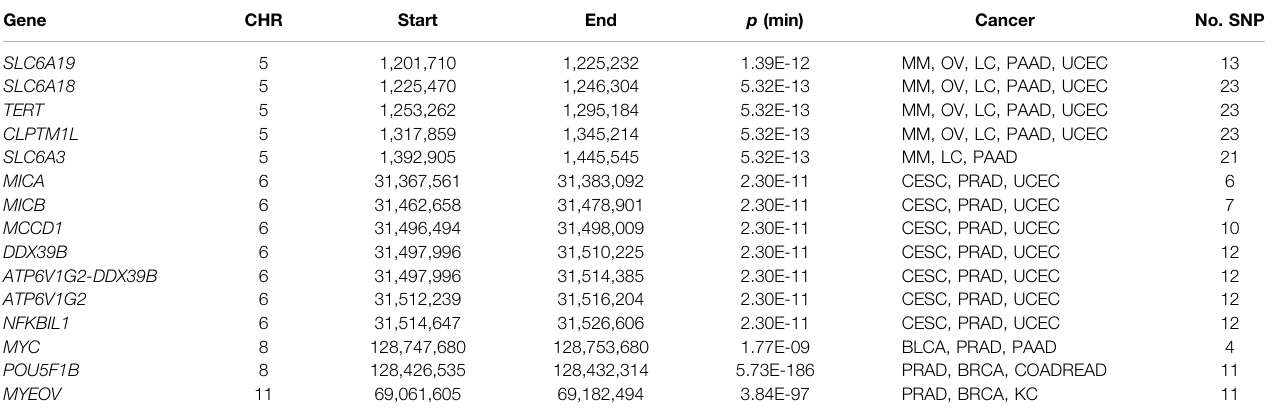
TABLE 2 | Summary of the 15 potential causal